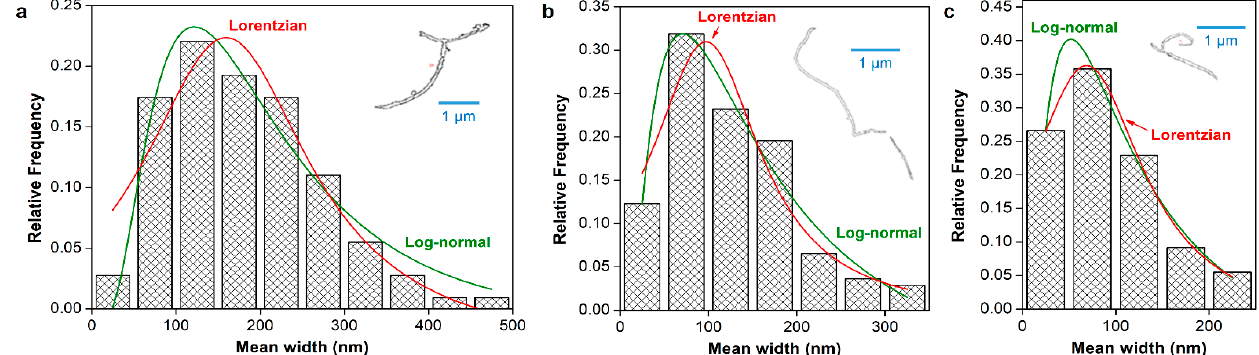
Figure 4. Width histograms of CNFs with different doses of hypochlorite during oxidation, namely 5 mmol/g ( a ), 10 mmol/g ( b ), and 15 mmol/g ( c ). The relative frequency is fitted to Lorentzian and log-normal distributions. Inset figures show outlined particles after binarization and isolation. Table 2. Estimation of the dimensions (length and diameter) of CNFs.